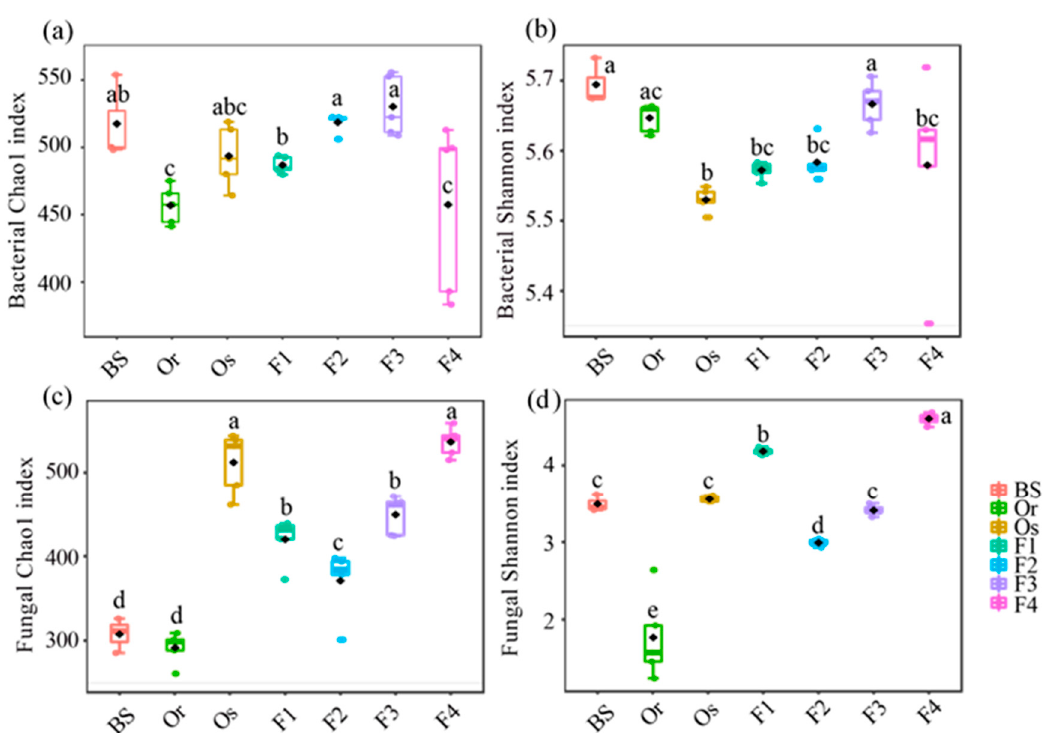
Figure 1. The α -diversity of the ( a , b ) bacterial and ( c , d ) fungal communities in bulk soil (BS) and the rhizospheres of the female parent Oryza rufipogon (Or) wild rice; male parent Oryza sativa (Os) cultivated rice; hybrid generation (F1); and the generations (F2, F3 and F4) obtained by self-crossing. Data with the same letters within each column indicate no significant difference by one-way ANOVA with LSD tests at p < 0.05.